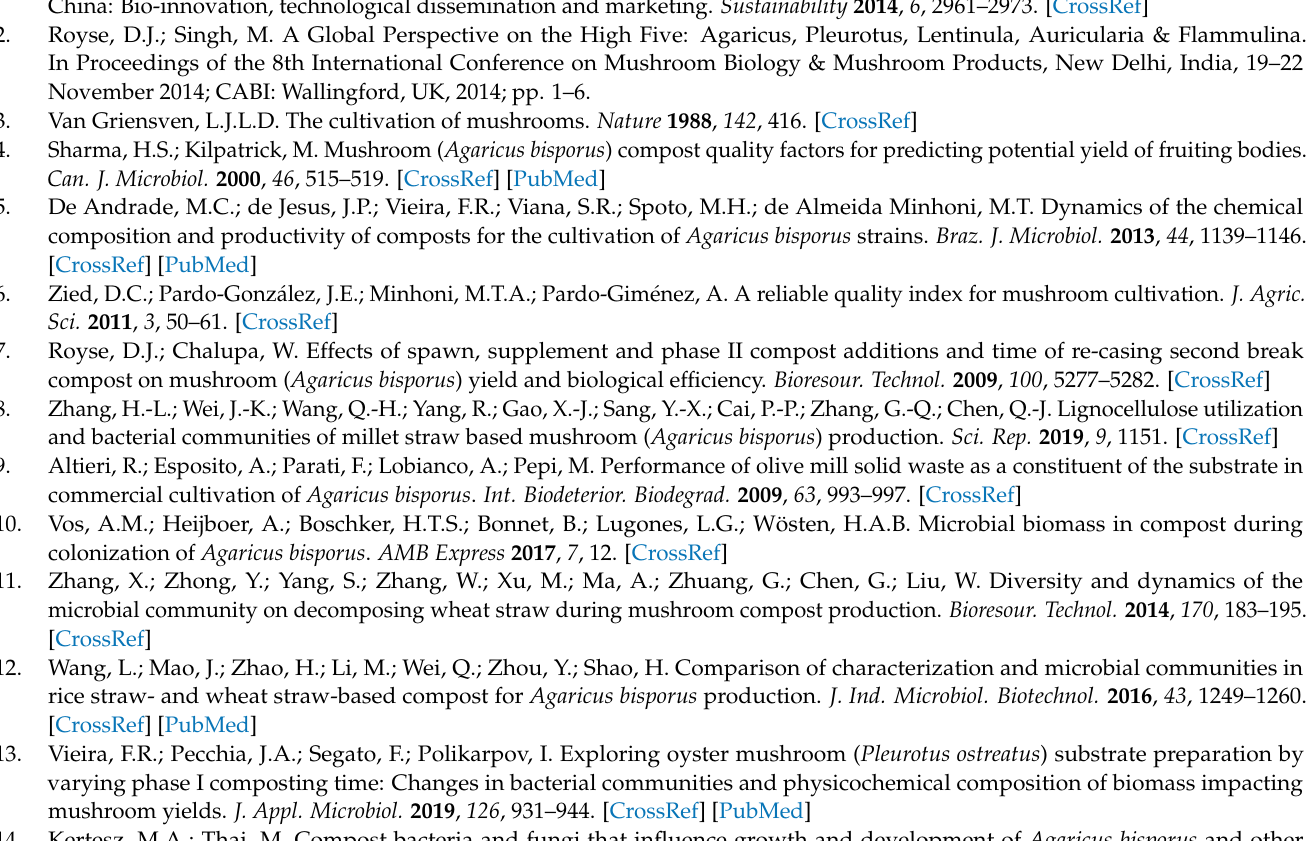
Table S2: Differential metabolites at different fermentation stages of the two